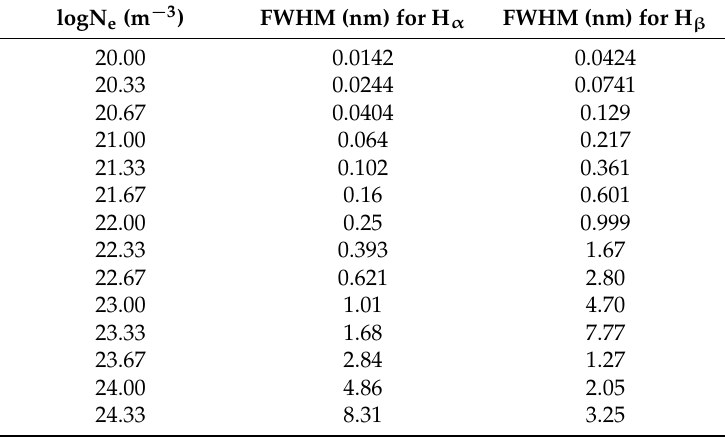
Table 3. FWHM (in nm) of H α and H β lines for μ = 0.9 (for Te = 10,000 K) [23]. logN e (m − 3